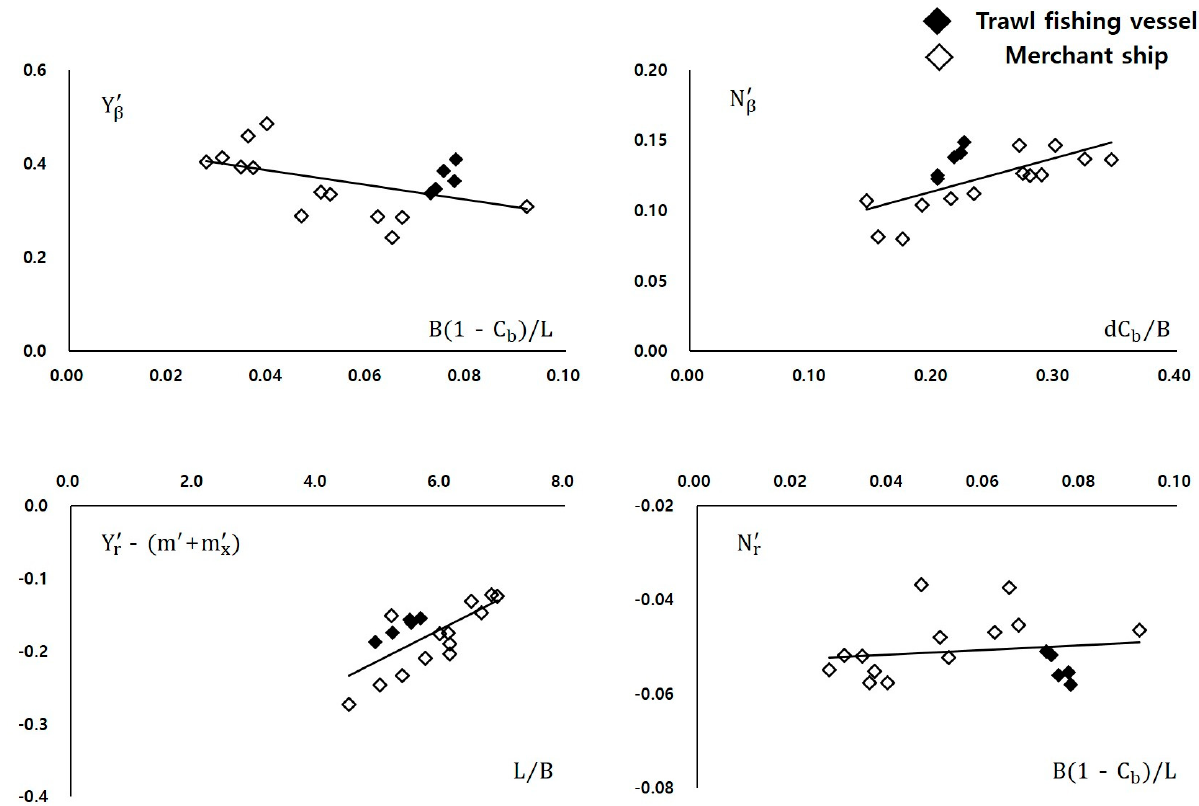
Figure 4. Correlations between linear derivatives and hull form parameters of the model ships.